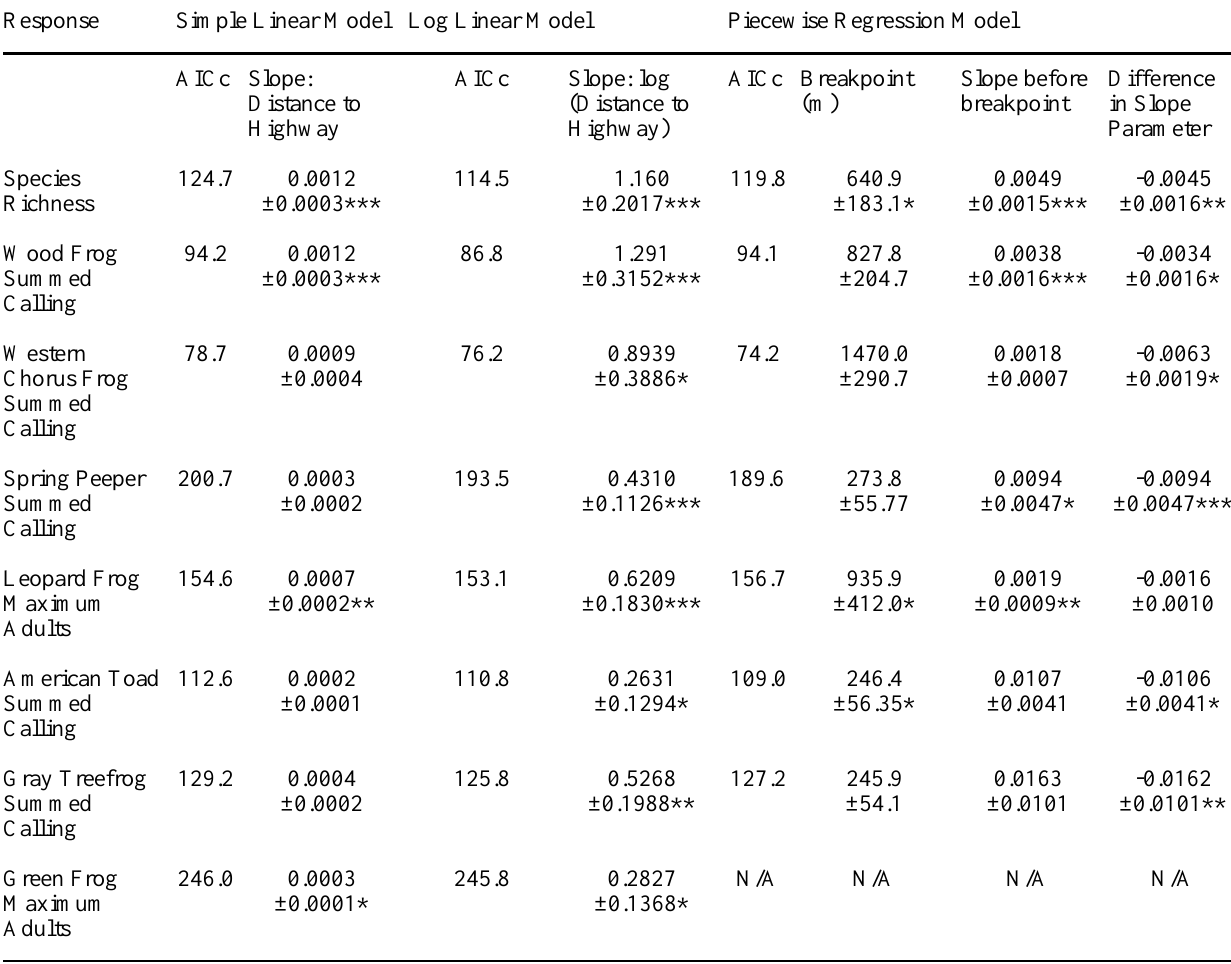
Table 1. Summary of statistical models (2006 data) of the relationships between anuran relative abundance and anuran species richness and distance to Highway 401 as measured by linear, log-linear, and piecewise regressions. In cases in which more than one breakpoint was estimated (*), only the estimate from the best- fitting model is shown. Statistical significance of the coefficients is indicated as follows: * P < 0.05; ** P < 0.01; *** P < 0.001. N/A indicates that no piecewise regression was attempted as no threshold was apparent from visual examination of the data. We used a Gaussian link function for species richness and a Poisson link function for the American toad; all other analyses use the negative binomial link